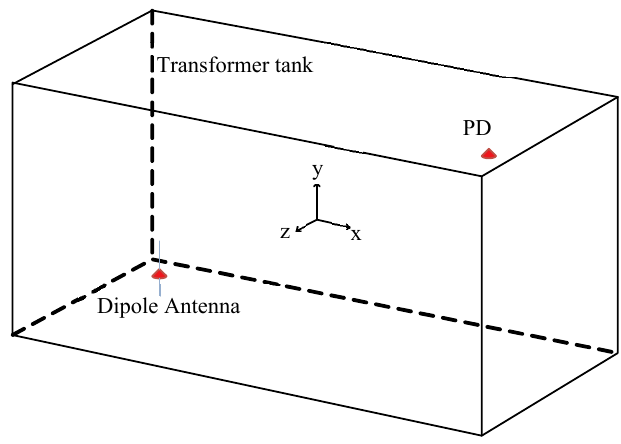
Figure 10. The geometry of the 3D transformer tank for